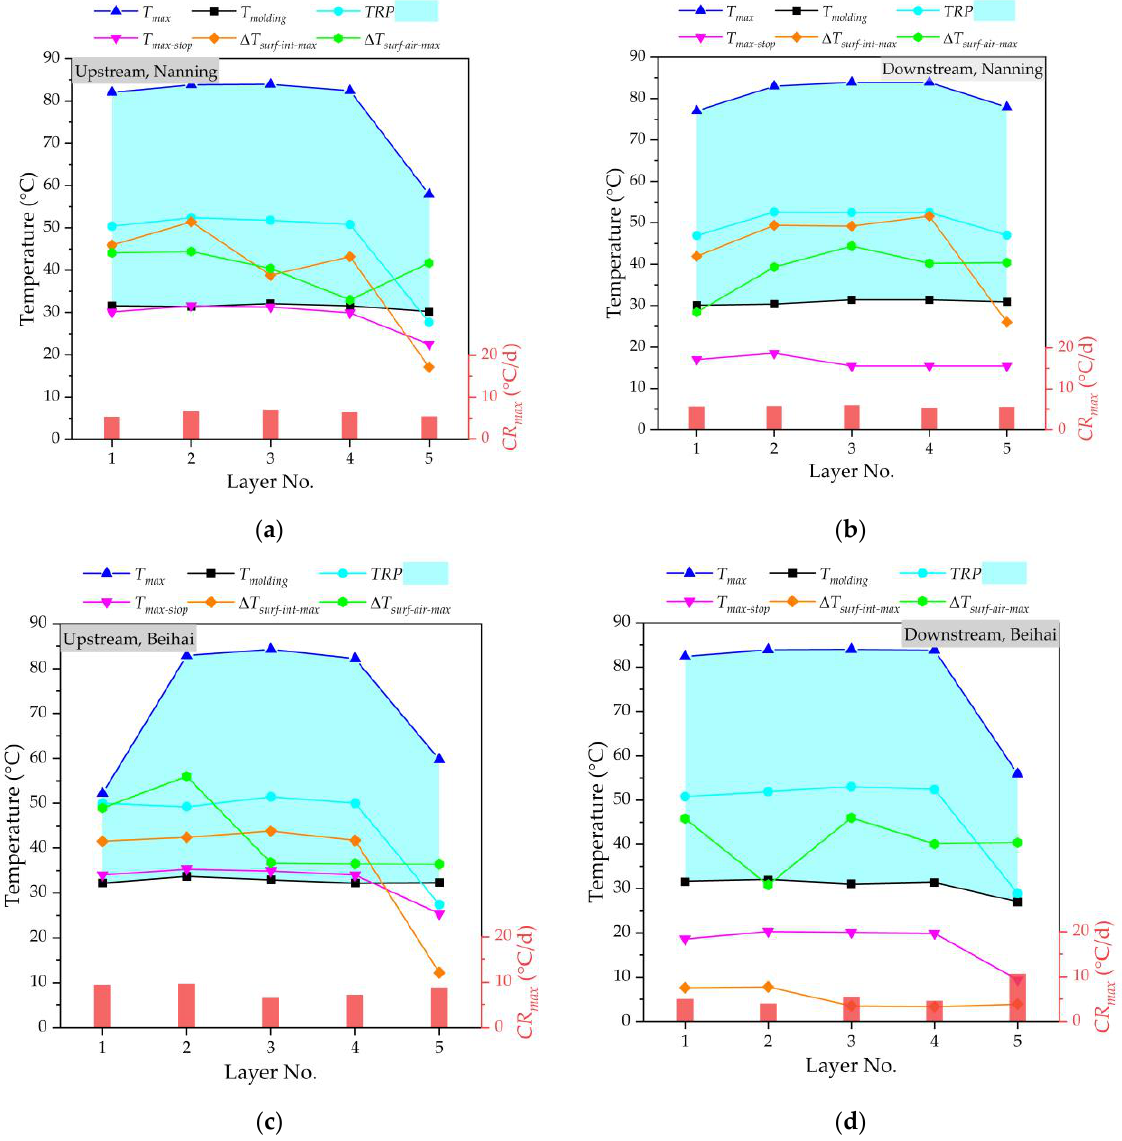
Figure 12. Temperature monitoring of mass concrete in arch abutment: ( a ) at the upstream of Nan- ning side; ( b ) at the downstream of Nanning side; ( c ) at the upstream of Beihai side; ( d ) at the downstream of Beihai side.